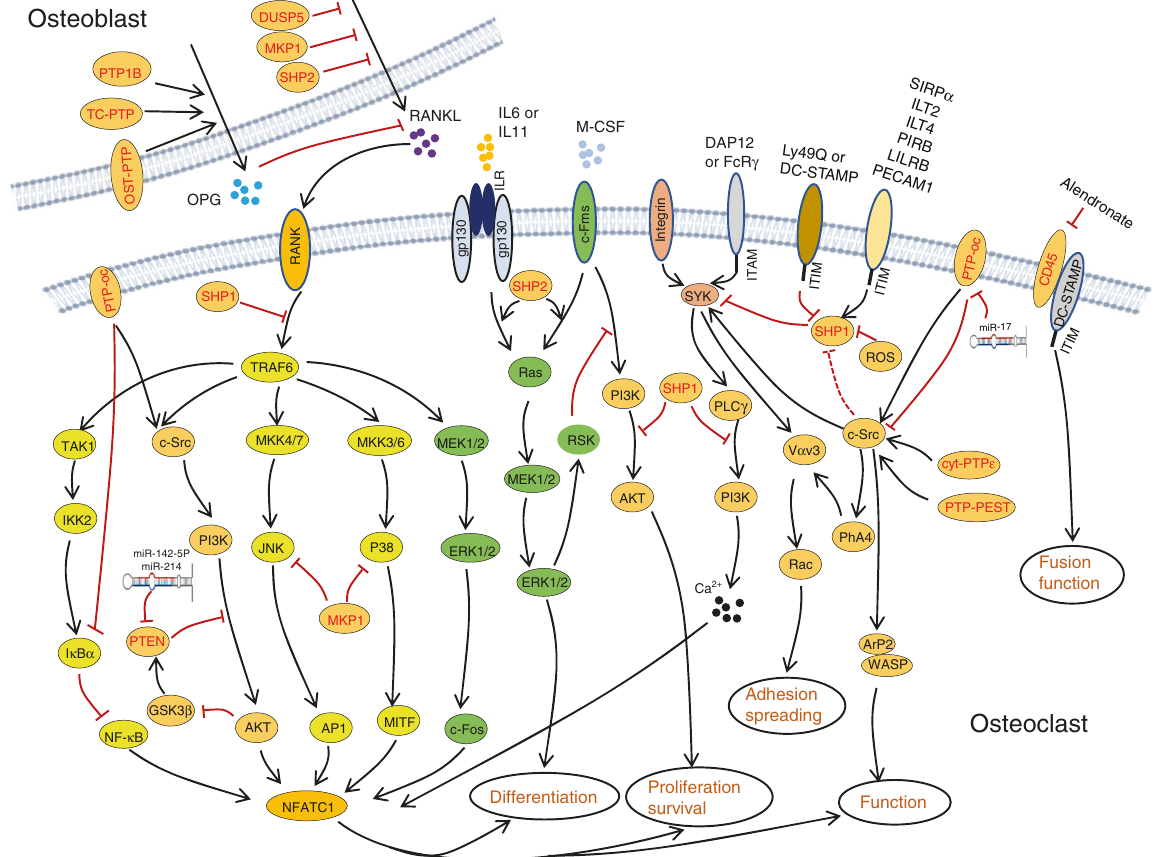
Fig. 7 PTPs regulate osteoclastogenesis by directly controlling multiple critical signaling pathways in osteoclasts and indirectly regulating synthesis and secretion of osteoclastic cytokines by OBs. Established signaling pathways are connected by lines with arrows or “ ┴ ” to indicate a promoting or inhibiting role during osteoclastogenesis. Involved PTPs are denoted in